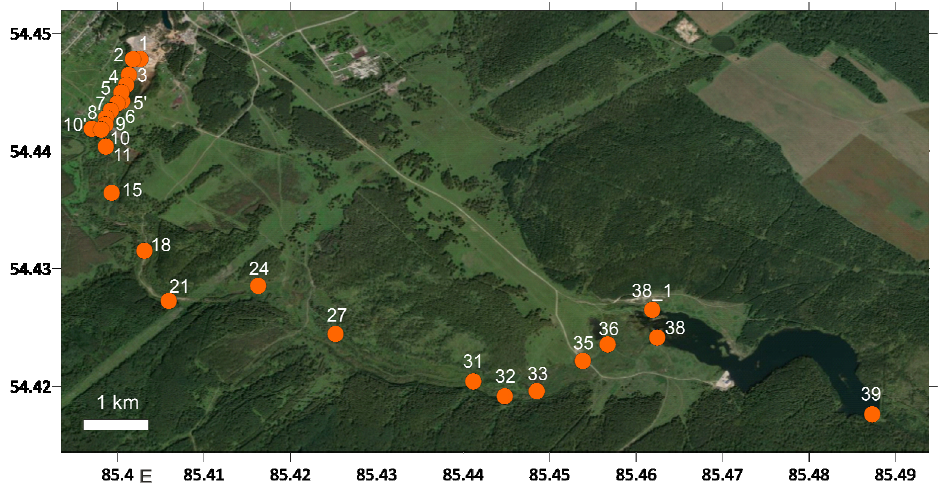
Figure 5. Scheme of hydrochemical sampling.